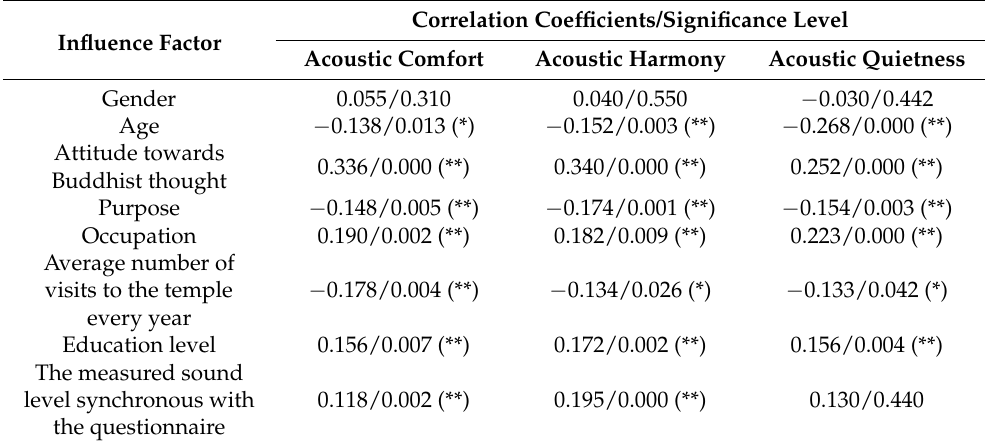
Table 4. Correlation between objective or subjective factors and temple acoustic environment